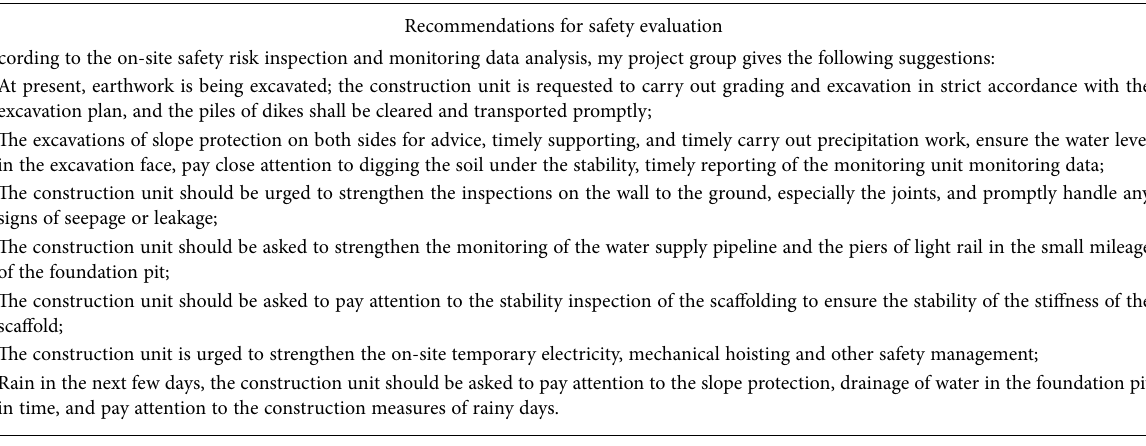
Figure 2. Example of a safety situation analysis (source: Wuhan metro construction safety early warning system) Table 1. Risk factors extracted form a safety situation